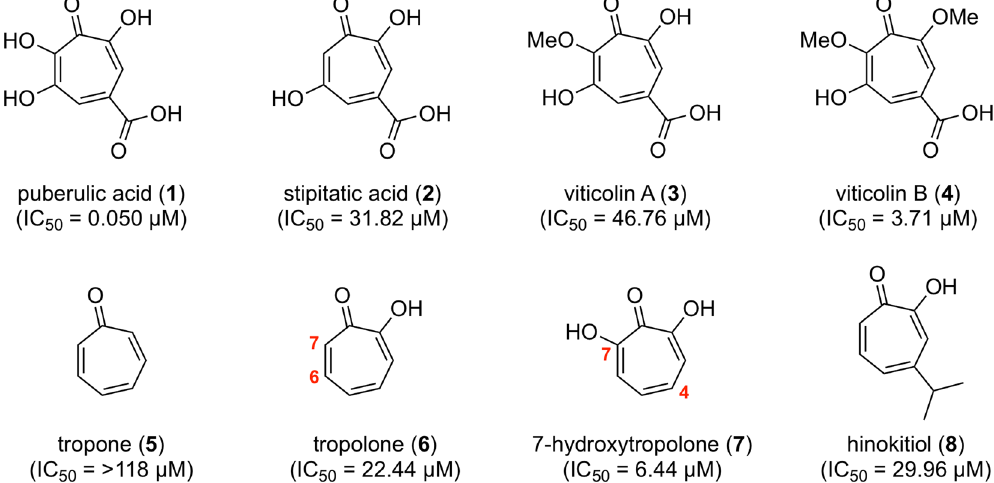
Figure 1. Antimalarial troponoids and their activity against Plasmodium falciparum K1 strain.